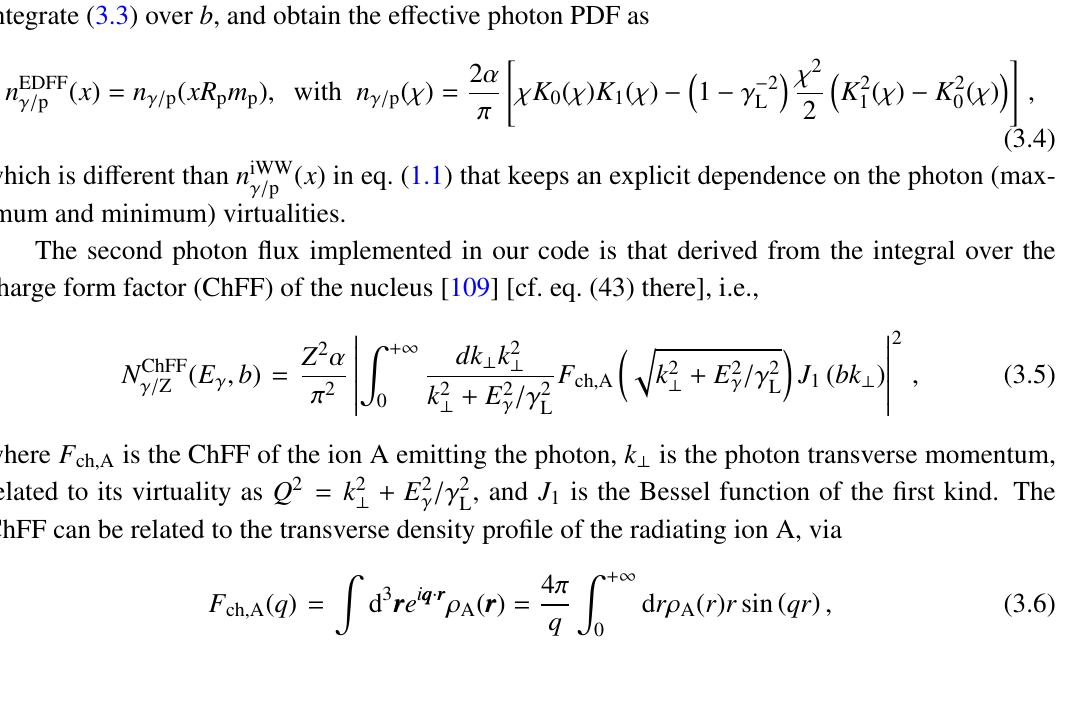
Figure 2 . Measurements of the low- j t j exponential elastic slope b 0 in p-p [100–106] and p-p [107] collisions p p s = s as a function of (individual data points at the same NN right to improve visibility). The orange curve shows our fit to the data, b 0 = A + B ln( s the parameters given in the